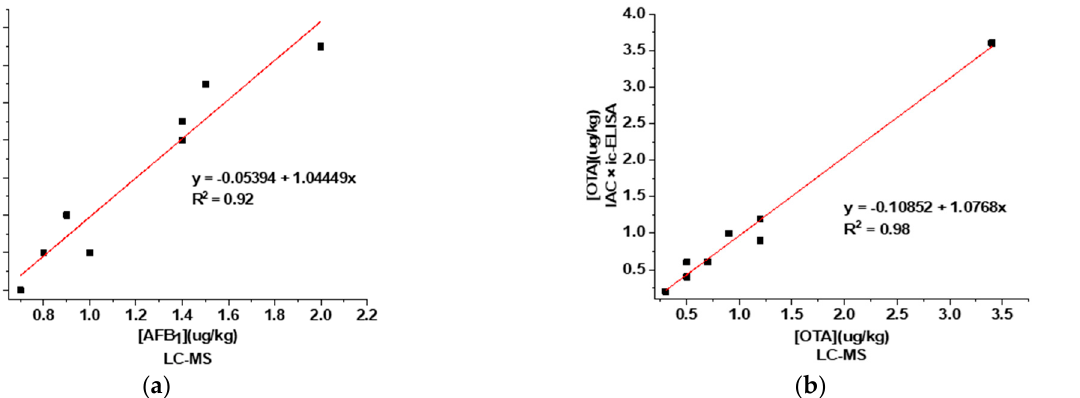
Figure 8. results of real sample detection by IAC-ELISA and LC-MS: ( a ) AFB 1 ; ( b ) OTA. Figure 8. Results of real sample detection by IAC-ELISA and LC-MS: ( a ) AFB 1 ; ( b )